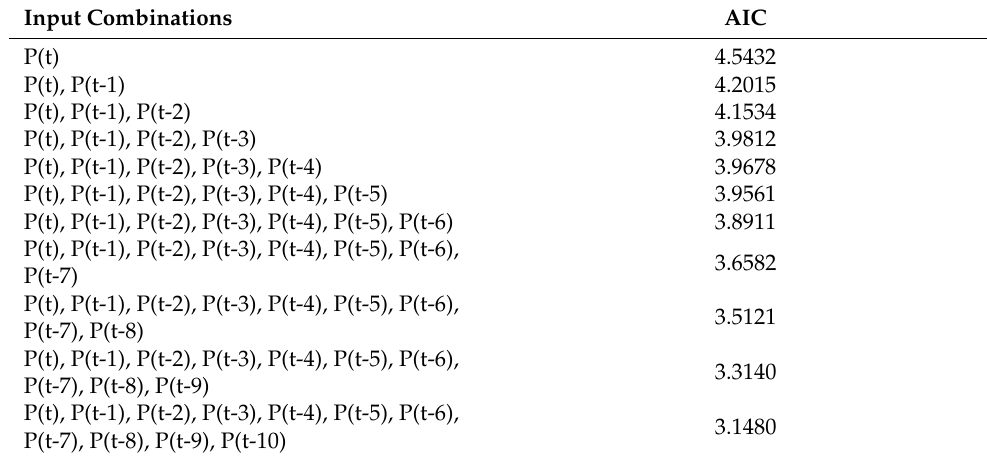
Table 2. The information criteria statistics of input combinations are used for runoff estimation.